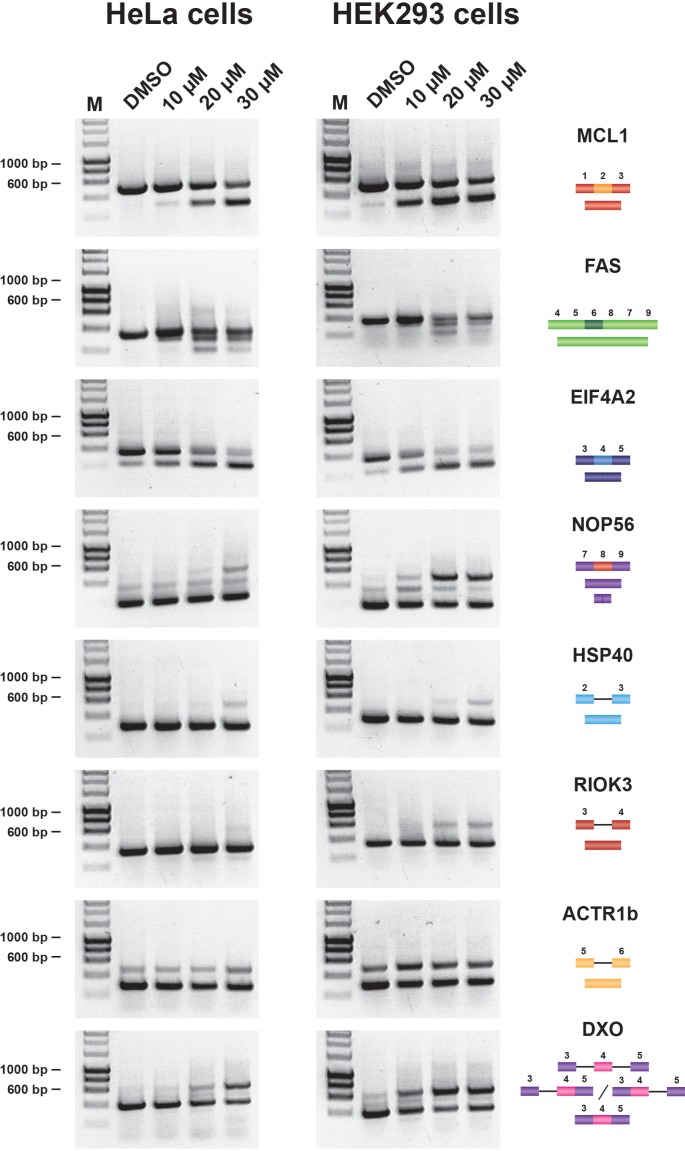
Isoginkgetin induces splicing changes in HeLa and HEK293 cells.Semiquantitative RT-PCR analysis of cells treated with increasing concentrations of either hinokiflavone, or DMSO control, for 24 hr. HeLa and HEK293 were examined for intron inclusion of HSP40, RIOK3, ACTR1b and DXO pre-mRNAs and for exon skipping of MCL1, NOP56, EIF4A2 and FAS pre-mRNAs. The positions of different cDNA products are pictured on the right of the gel image and the molecular weight markers are shown on the left. Lane M, marker (hyperladder, 1 kb).